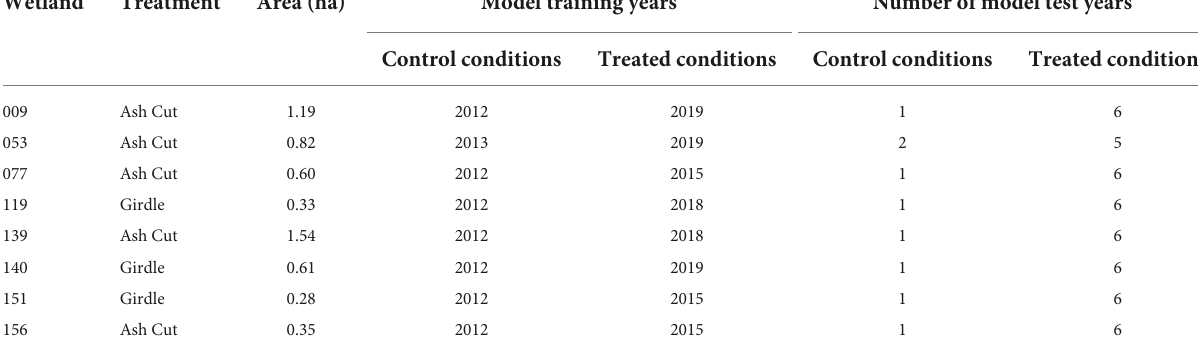
TABLE 1 Wetland size and treatment for field-study sites and 2012–2020 water year records used to develop wetland water level models. Wetland Treatment Area (ha) Model training